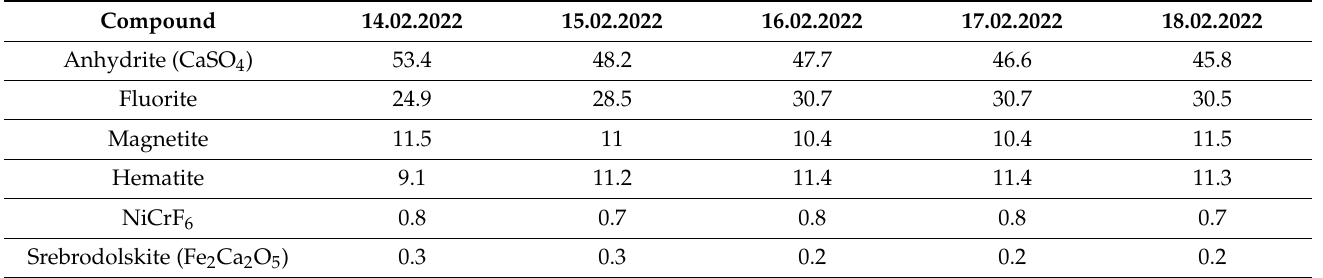
Figure 4. Diffractograms of the five samples calcined at 900 °C with overlapping of the same. ( a ) Sample from 14-02-2022, ( b ) Sample from 15-02-2022, ( c ) Sample from 16-02-2022, ( d ) Sample from 17-02-2022, ( e ) Sample from 18-02-2022, ( f ) Overlapping of the previous diffractograms with iden- tification of the main peaks. The Rietveld refinement of the diffractograms allowed us to estimate the compound compositions indicated in Table 4. Table 4. Estimated compound compositions of the samples calcined at 900 ◦ C obtained by the Table 4. Estimated compound compositions of the samples calcined at 900 °C obtained by the Rietveld refinement method. Rietveld refinement method.